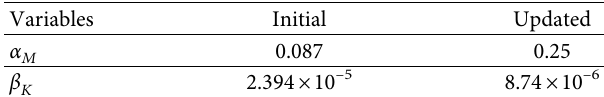
Table 10: Comparison of the parameters of the Rayleigh damping model before and after updating.